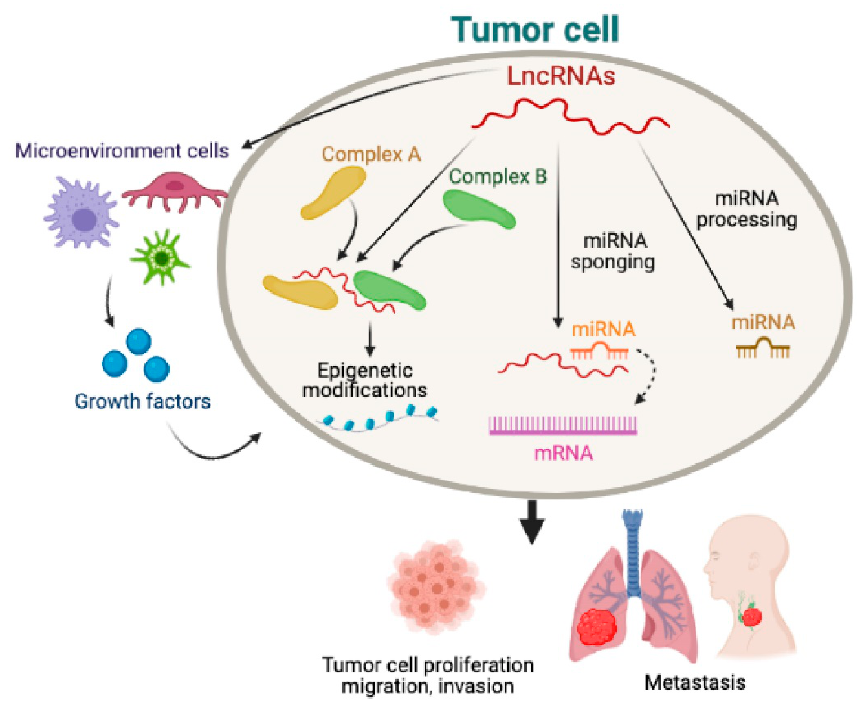
Figure 1. Representative regulatory networks of long non-coding RNAs (lncRNAs) in human tumor cells. Some tumor-derived lncRNAs may be processed into micro RNAs (miRNAs) which can function as tumor suppressors or promoters. LncRNAs may also act as a sponge for some miRNAs which cannot bind to mRNAs. LncRNA may cause genome-wide epigenetic modifications through binding to proteins or protein complexes and control different cellular functions. Tumor-derived lncRNAs also regulate growth factor secretion from the microenvironment of non-tumor cells, leading to metastasis and ultimately to tumor progression.